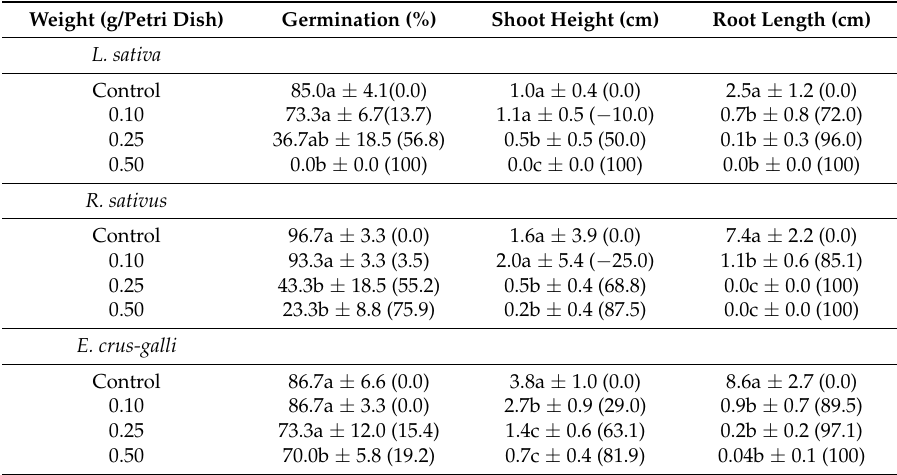
Table 1. Effects of C. crenata dried leaf powder on germination and root and shoot growth of L. sativa , R. sativus , and E. crus-galli.